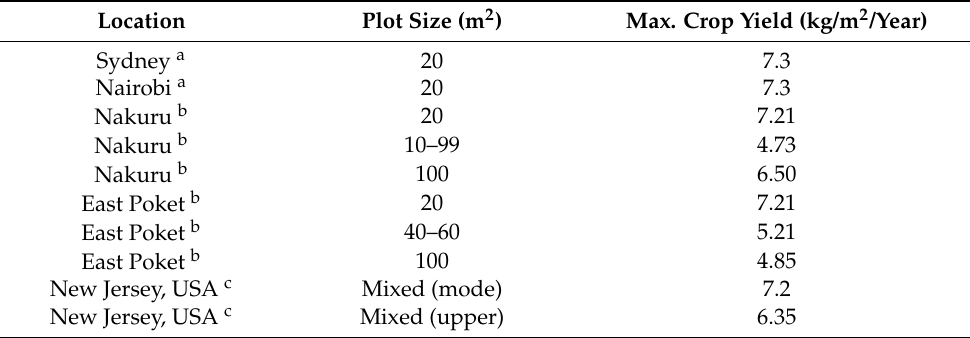
Table 3. Average yield (kg/year) comparisons for various plot